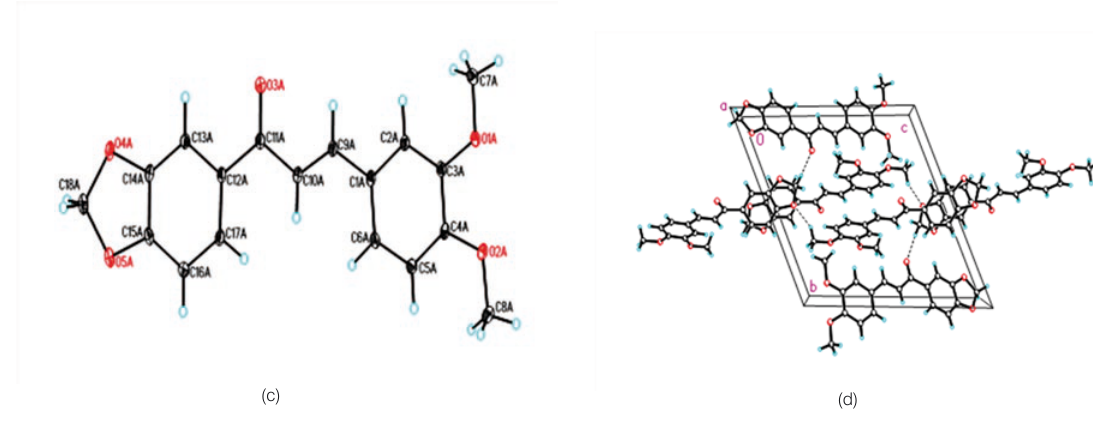
Figure 2. Ortep drawings (c) and molecular packing (d) for (2E)-1-(1,3-benzodioxol-5-yl)-3-(3,4-dimethoxyphenyl)prop-2-en-1-one